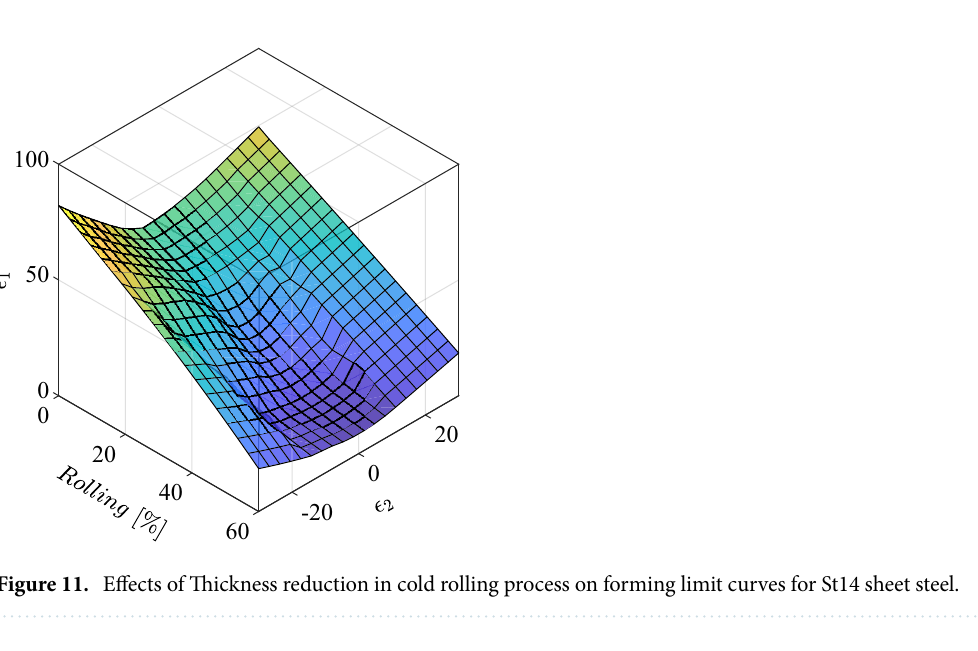
Figure 10. Comparison of the outputs of ANFIS and experimental values for both training and testing data.